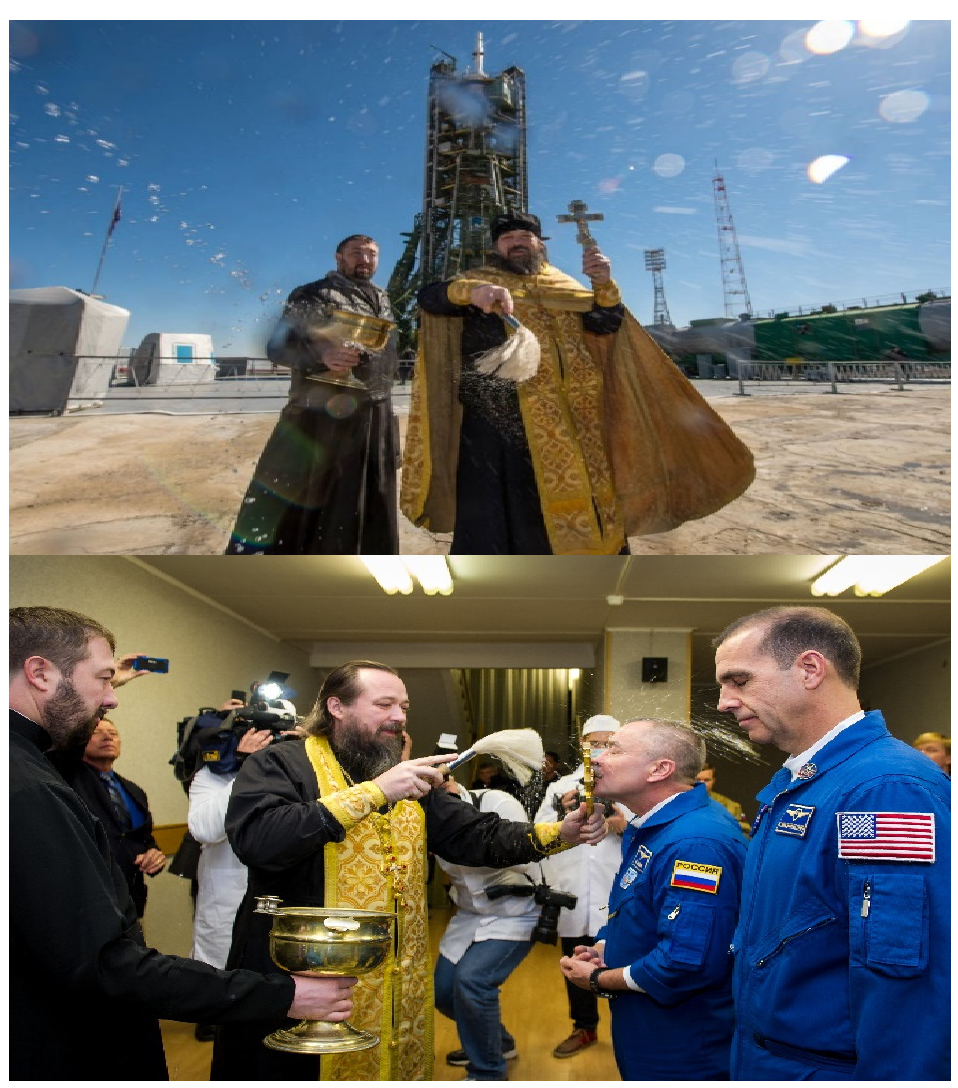
Figure 2. An Orthodox priest blesses members of the Soyuz rocket © Philip Scott Andrews: https://time.com/3759467/rocket-blessing-soyuz/ (accessed on 24 October 2022). During the 2000s space projects, other astronauts started to reveal their religious back‑ grounds. Sunita Williams, of Hindu origin, brought a personal copy of the Bhagavad Gita (a part of the epic Mahabharata ) to the ISS in 2006, as well as an Om picture (a sacred spiritual symbol) and the Upanishads (